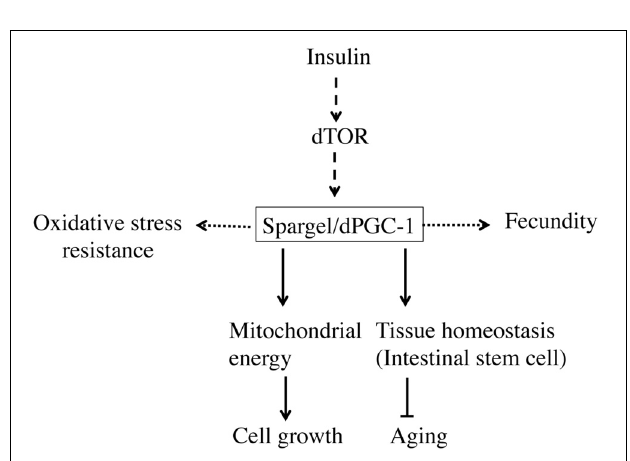
FIGURE 3 | Possible requirement of Spargel/dPGC-1 during oogenesis. (A) Mature ovaries from spargel hypomorph srl 1 females are much smaller in size with respect to the control ovaries of same age, (B) Quantification of number of ovarioles suggest srl 1 ovaries carry about 40% less number of ovarioles with respect to the wild type ovaries. (C) Time course analysis of oogenesis shows srl 1 ovaries matures more slowly in comparison to the wild type ovaries (PE, post eclosion). ∗∗∗ P < 0 . 001.